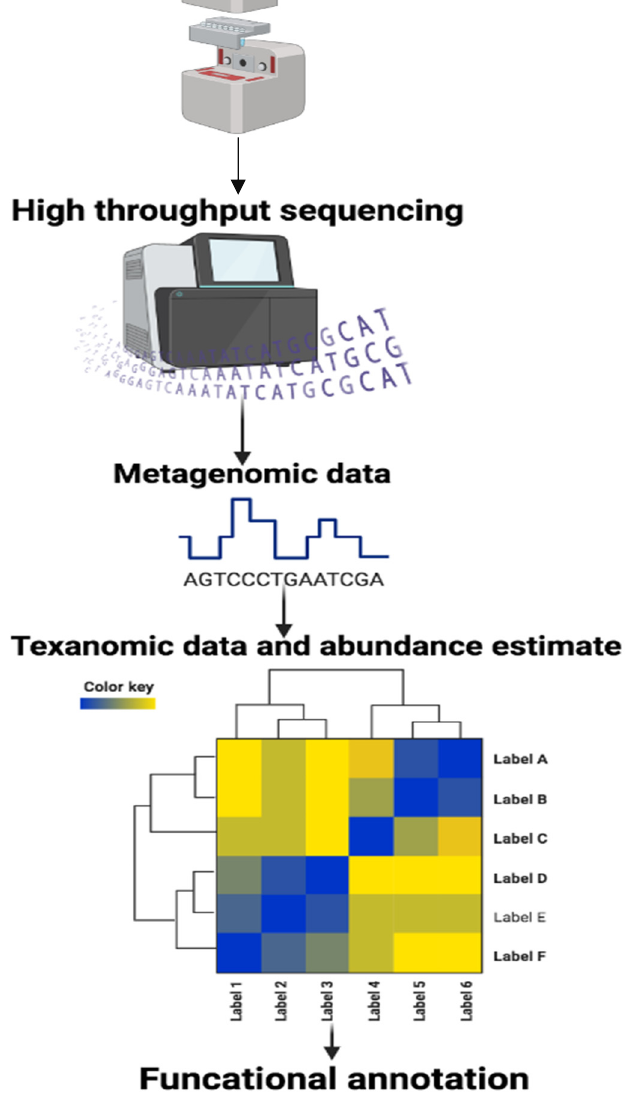
Figure 3. Overview of key steps involved in metagenome